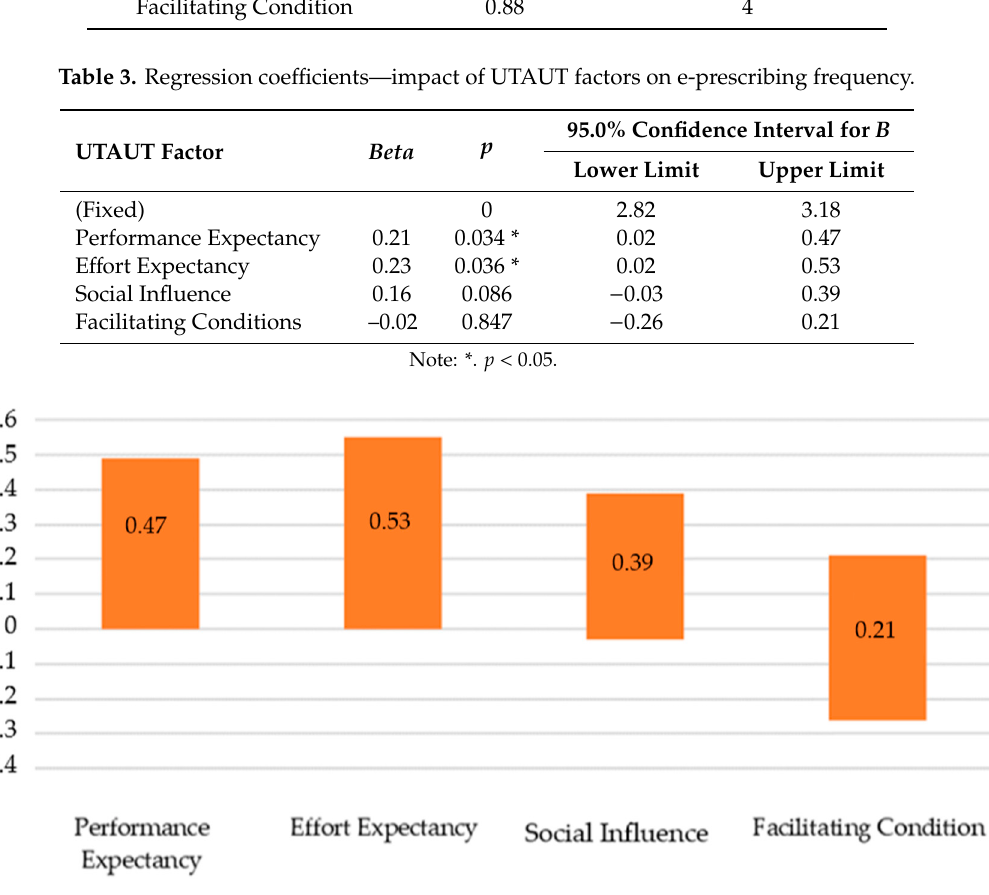
Figure 4. Percentage distribution of responses to questions in the Performance Expectancy section. 29.37%